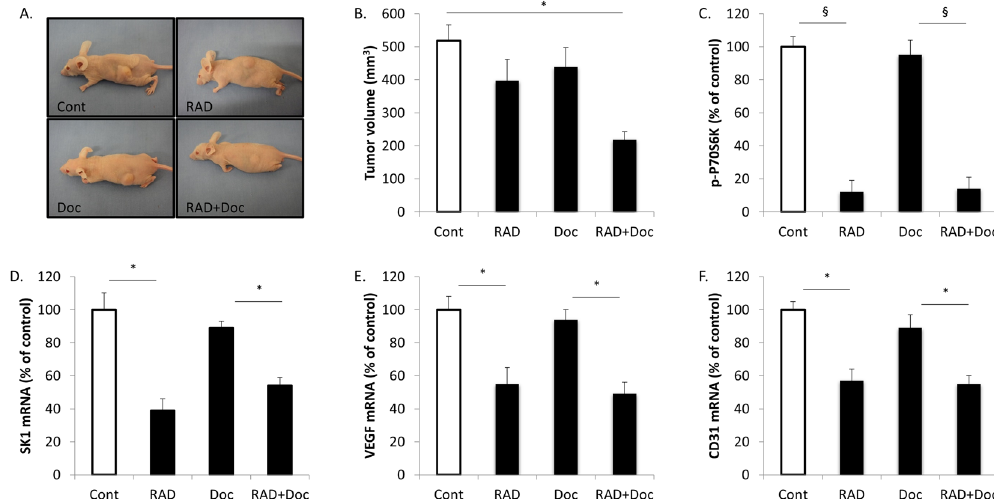
Figure 6. RAD001 decreases tumour vasculature in mouse model of human prostate cancer. Subcutaneous PC3 tumours were established in nude mice as described in materials and methods and allowed to grow for two weeks. Mice were treated with sham (Cont), 5 mg/kg RAD001 (RAD), 5 mg/kg docetaxel (Doc) and combination of these drugs (RAD + Doc) for three weeks. ( A ) Representative images of subcutaneous human tumours in mice after corresponding treatments. ( B ) Tumour volumes at week five. ( C ) P70S6K phosphorylation in tumours was measured using ELISA. ( D–F ) Human SK1 ( D ), VEGF ( E ) and mouse CD31 ( F ) expression was determined by qRT-PCR. Columns, mean values of n = 8; bars, SEM. ( * P < 0.05; ** P < 0.01; § P < 0.001; ns, not significant, P >